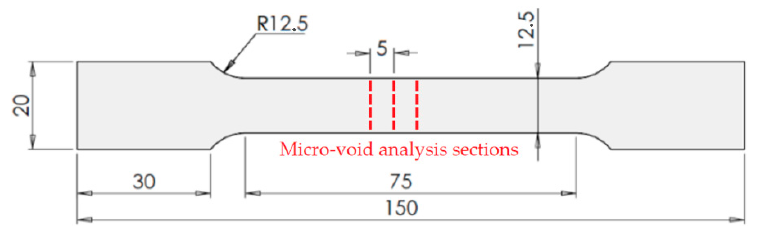
Figure 2. Geometry, dimensions (mm) of the uniaxial tensile test specimen, and slices cut from the gauge length region for the void formation analysis.